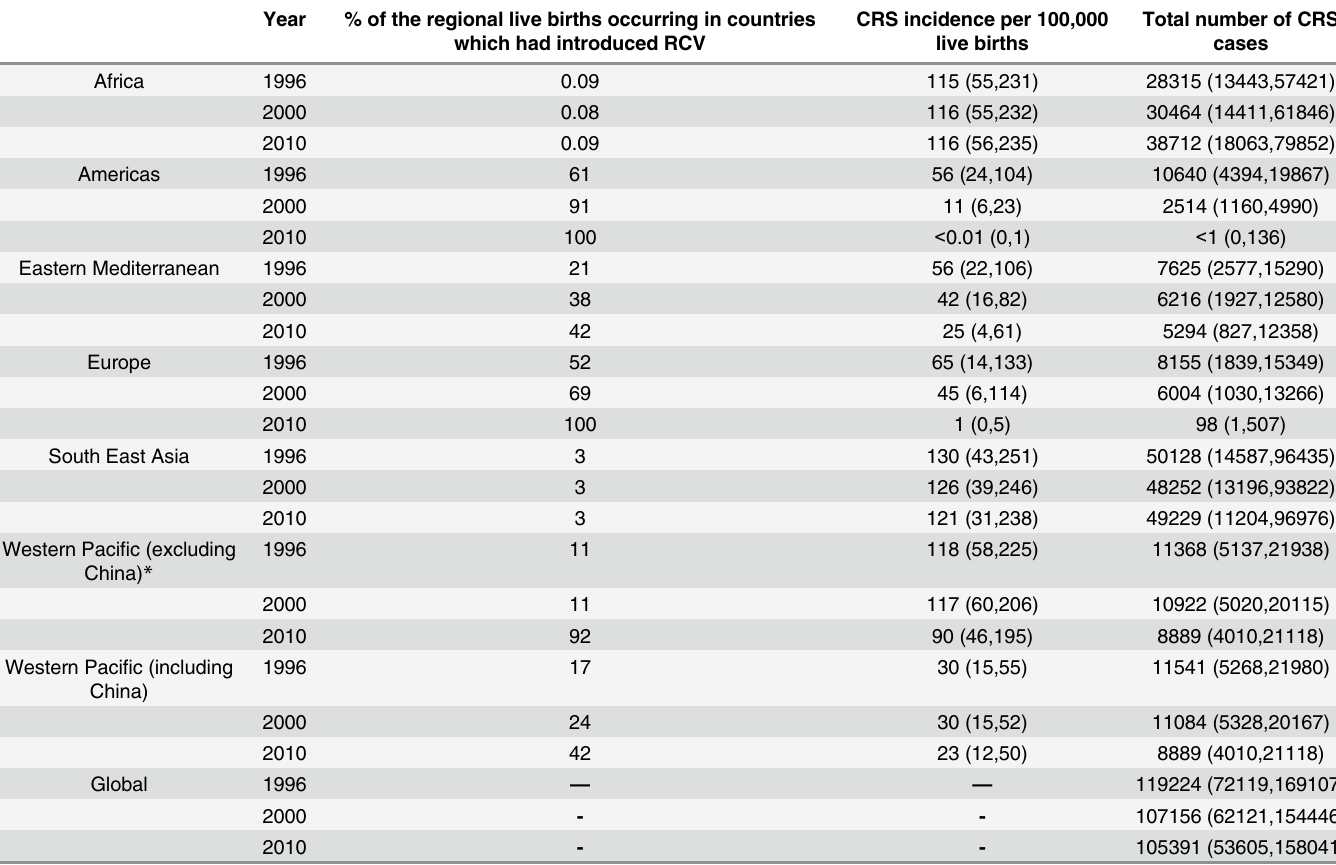
Table 5. The median CRS incidence per 100,000 live births and number of CRS cases born in each WHO region and worldwide in 1996, 2000 and 2010 and the percentage of the regional birth cohort living in countries which had introduced RCV by these years. Year % of the regional live births occurring in countries which had introduced